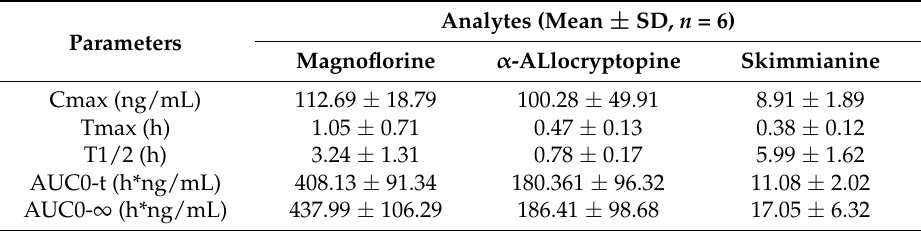
Figure 7. Plasma concentration-time curves of analytes. Figure 7. plasma concentration-time curves of analytes. Table 5. Pharmacokinetic parameters of analytes in rats after oral Table 5. Pharmacokinetic parameters of analytes in rats after oral administration.